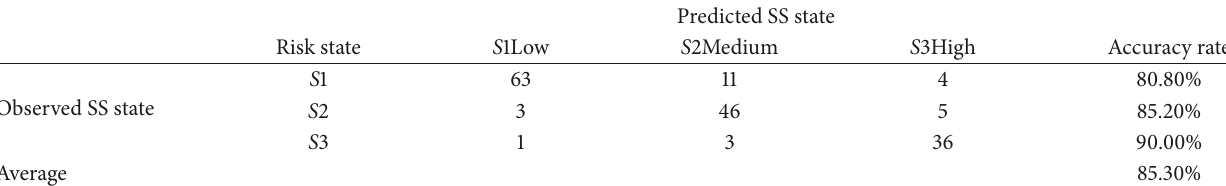
Table 7: SS prediction results based on test